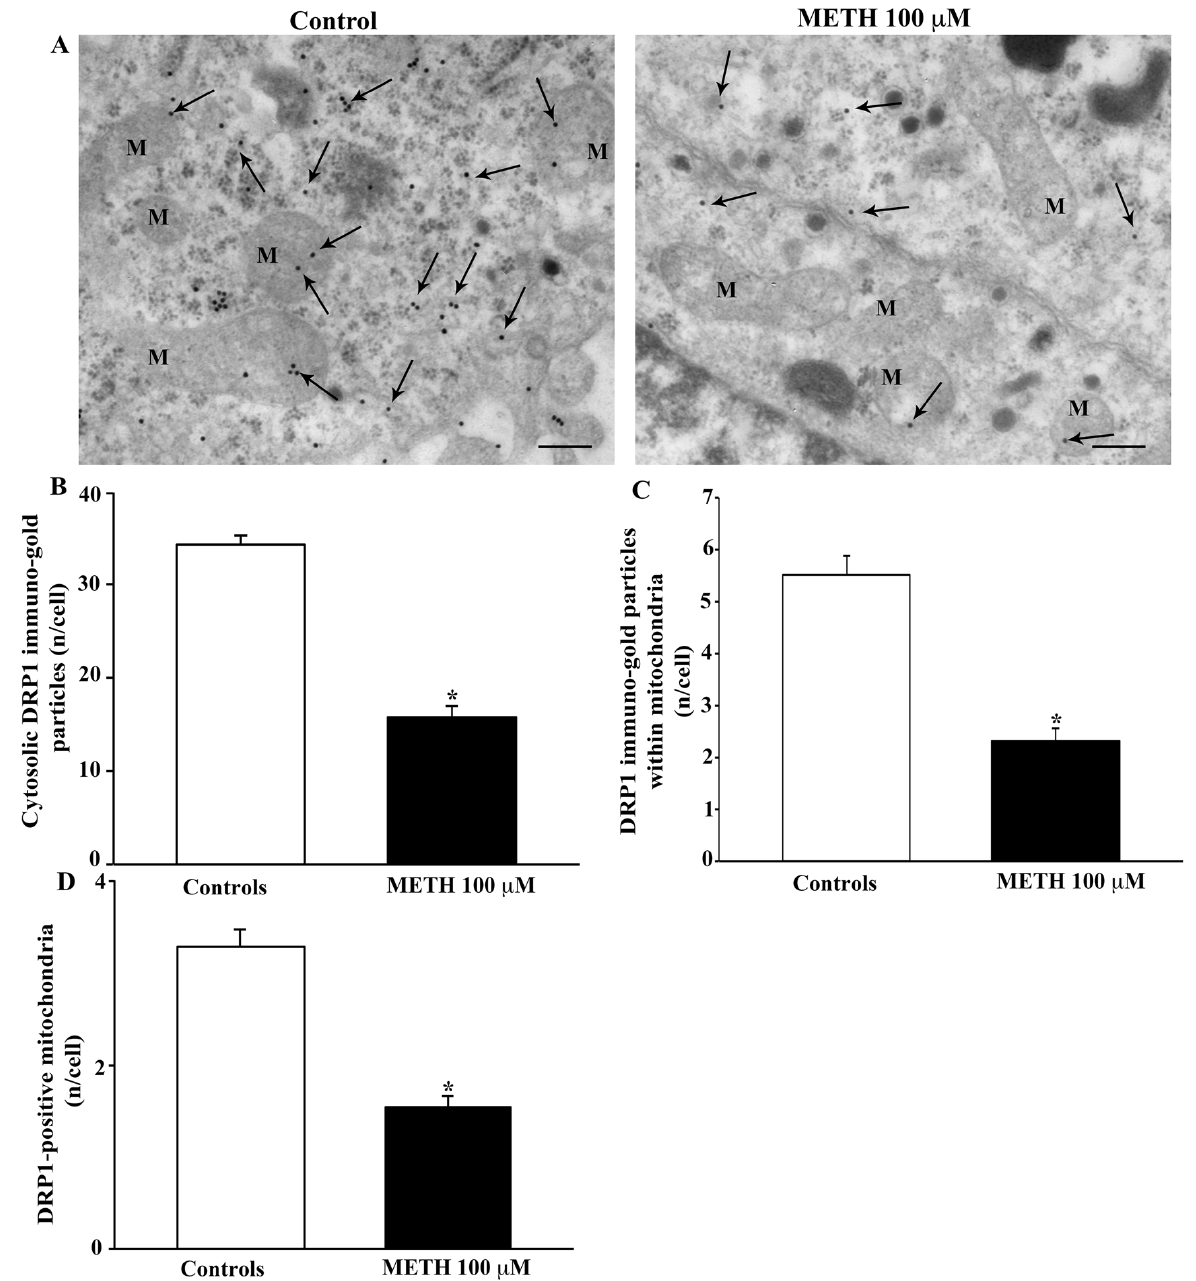
Figure 13. METH decreases the fission protein DRP1. ( A ) Representative TEM micrographs showing DRP1 particles from control and following METH 100 μ M. Arrows point to DRP1 immunogold particles within cytosol and mitochondria (M). Graph ( B ) reports the number of DRP1 immunogold particles within the cytosol. Graph ( C ) reports the number of DRP1 immunogold particles within mitochondria. Graph ( D ) indicates the number of DRP1-positive mitochondria. Values are given as the mean ± S.E.M from N = 50 cells per group. * p ≤ 0.05 compared with controls. Scale bars = 170 μ m.